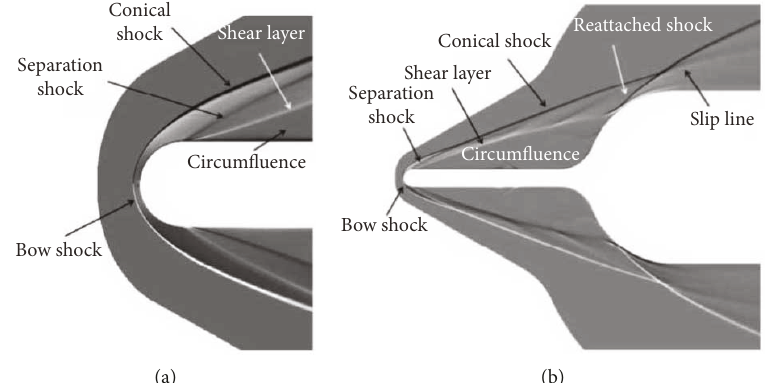
Figure 15: Density gradient in the y direction shows typical fl ow fi eld wave structure around the pure spiked blunt body (Ma =6.0, L / D =1.0): (a) fl ow around the spike nose; (b) fl ow around the whole body.